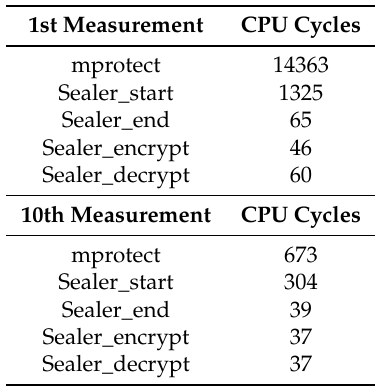
Table 2. Performance numbers of Sealer. First and tenth measurements display the performance difference due to